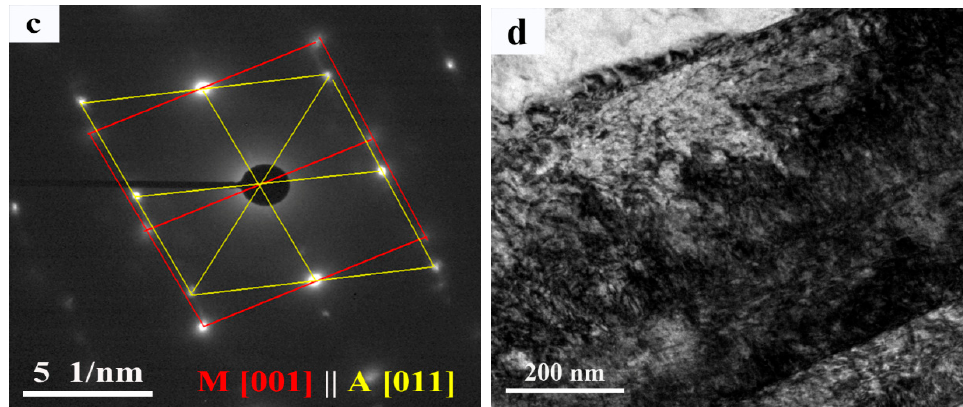
Figure 7. TEM images of weld; ( a ) and ( b ) Bright and dark field image of the weld metal respectively; ( c ) Selective area diffraction pattern of the weld metal; and ( d ) Dislocations inside martensite lath of the weld metal.